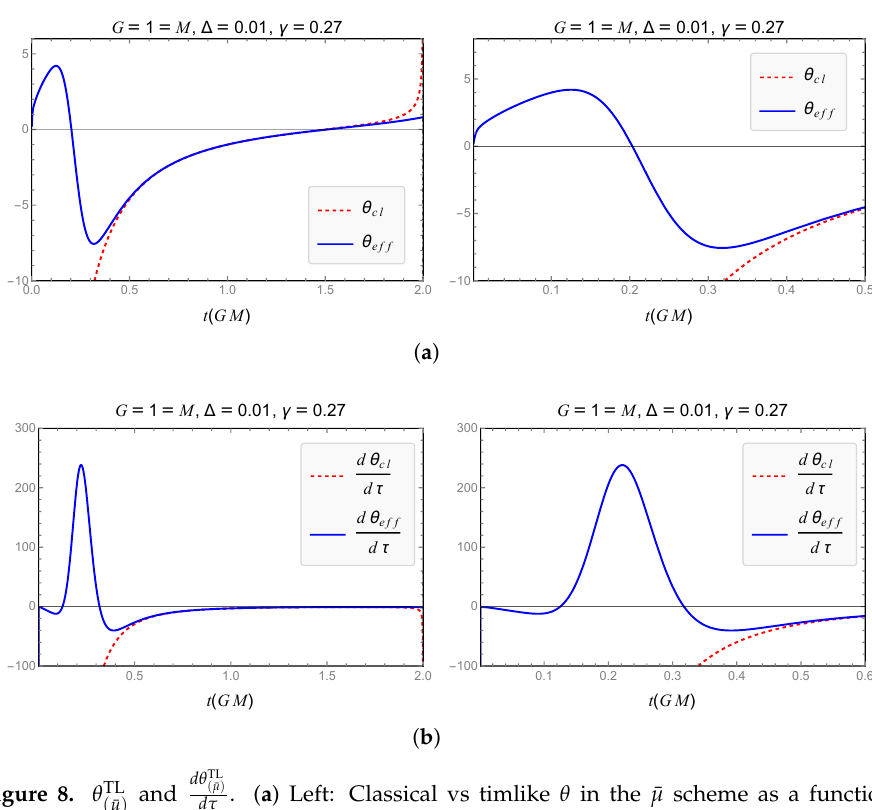
d θ TL ( ¯ µ ) Figure 8. θ TL and . ( a ) Left: Classical vs timlike θ in the ¯ µ scheme as a function of the ( ¯ µ ) d τ Schwarzschild time t . The effective expansion θ TL goes to zero as t → 0. Right: Close up of ( ¯ µ ) the left figure close to t = 0. ( b ) Left: Classical vs. timlike d θ in the ¯ µ scheme as a function of the d τ d θ TL ( ¯ µ ) Schwarzschild time t . The effective goes to zero as t → 0. Right: Close up of the left figure close d τ to t =